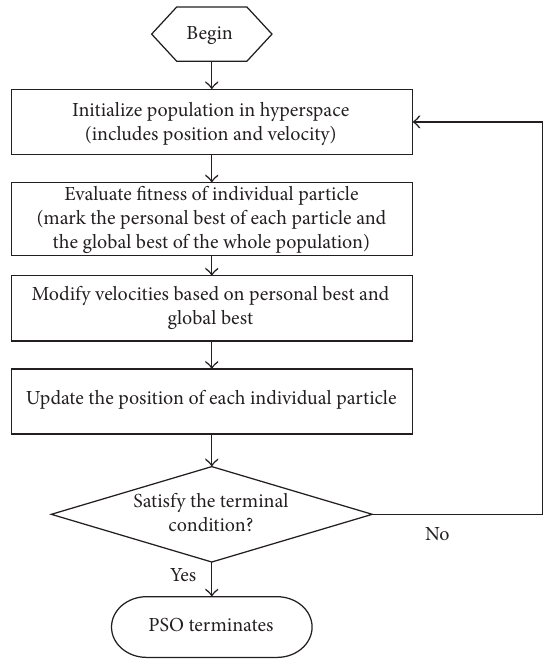
Figure 1: PSO algorithm